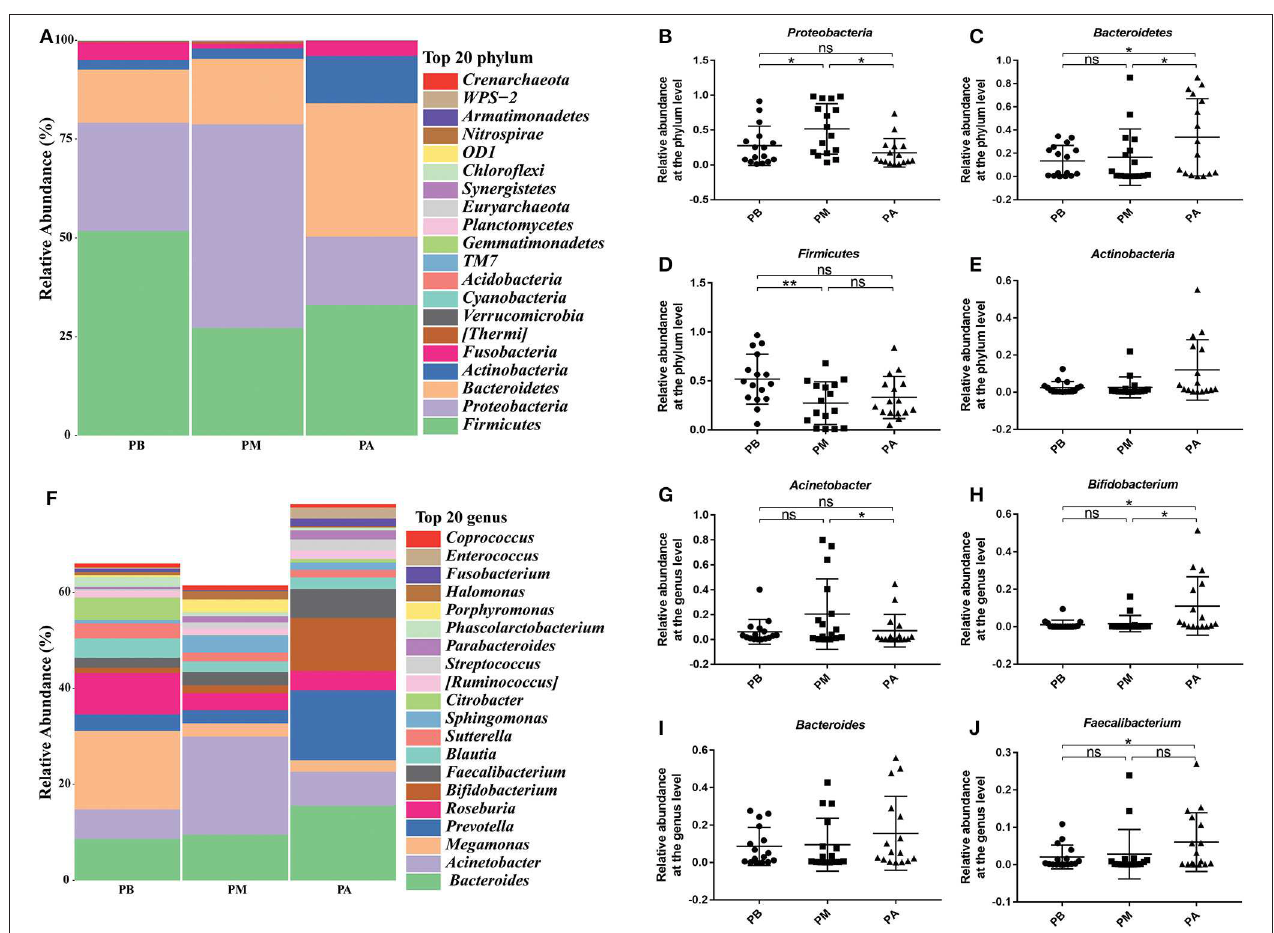
FIGURE 4 | Effect of probiotics on microbial composition at phylum and genus levels. (A) , the relative abundance of intestinal microbiota at the phylum level; (B) , Proteobacteria ; (C) , Bacteroidetes ; (D) , Firmicutes ; (E) , Actinobacteria . (F) , the relative abundance of intestinal microbiota at the genus level; (G) , Acinetobacter ; (H) , Bifidobacterium ; (I) , Bacteroides ; (J) , Faecalibacterium . PB, probiotic group 3 days before bowel preparation ( n = 16); PM, control group during bowel preparation ( n = 16); PA, probiotic group 5–7 days after bowel preparation (Supplement the Bifidobacterium Tetragenous viable Bacteria Tablets after colonoscopy for up to 5–7 days, three tablets and three times a day) ( n = 16). Data are presented as means ± SD. ns, P > 0.05; * P < 0.05; ** P <